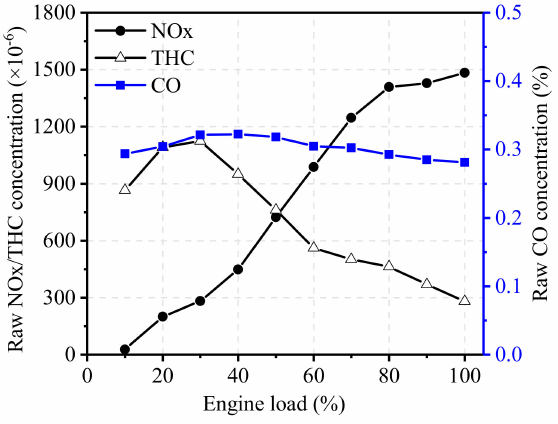
Figure 9. E ff ect of engine load on exhaust